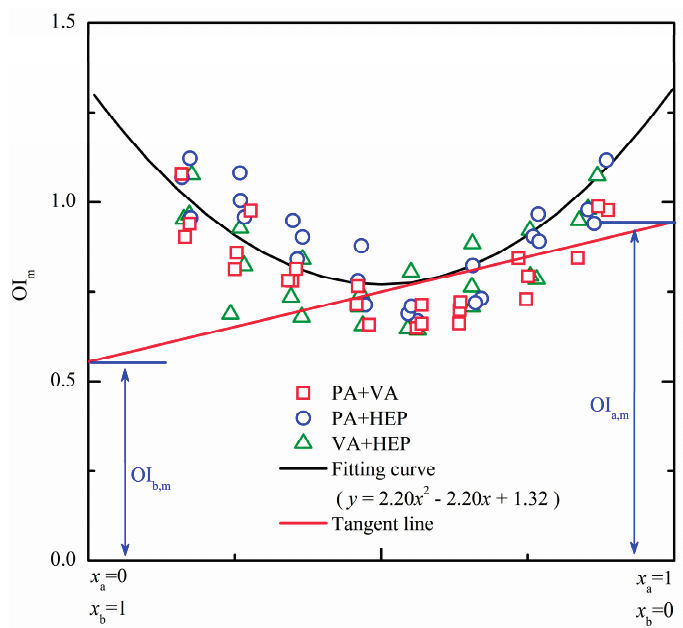
Figure 6. The extended PDE model for binary odor mixture of aldehydes. The red line was a tangent line on the fitting curve at point (0.6, 0.8), and its intercepts on the vertical axes were partial differential odor intensities (OI a,m and OI b,m